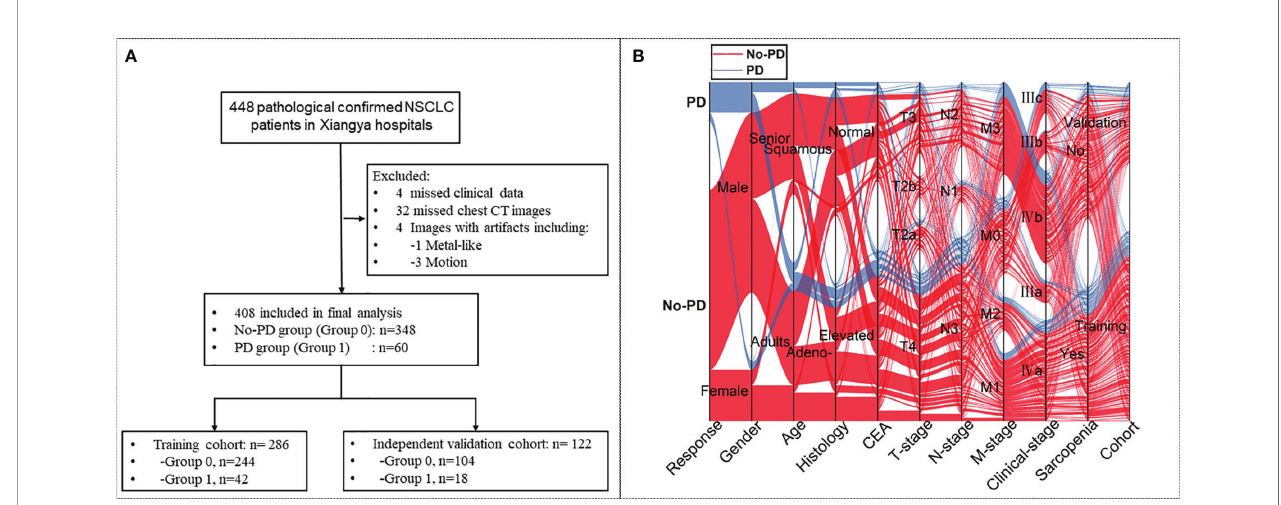
FIGURE 1 | (A) Flow-chart demonstrating the recruiting process for patients with non-small-cell lung cancer (NSCLC) with or without progressive disease (PD). (B) Sankey diagram showing the scmap cluster projection of the outcome of the cases, gender, age, pathological type, expression of carcinoembryonic antigen (CEA), cancer staging, body mass index (BMI), sarcopenic status, as well as the cohort information in the predictive